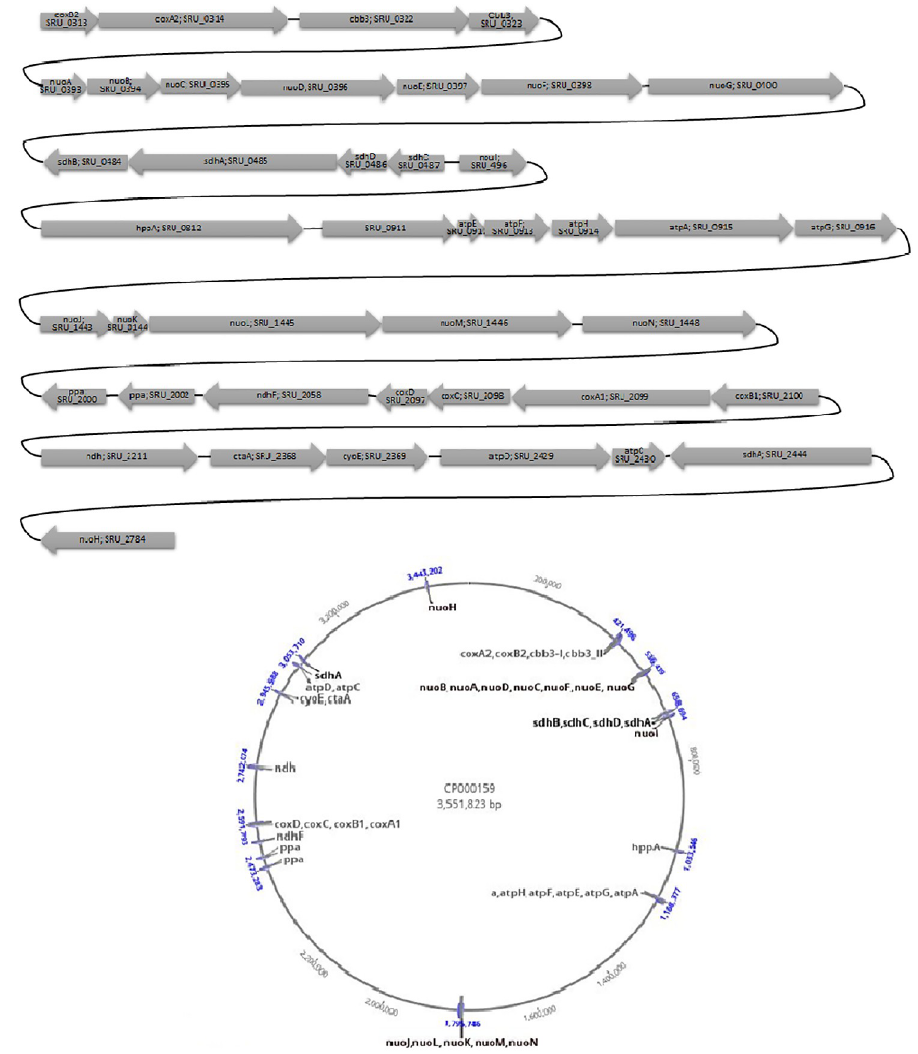
Fig 2. Phosphorylation oxidative genes in S . ruber . (A). gene direction and related position of their related position to each other. (B). distribution of gene clusters in the genome. Totally 42 genes were related to oxidative phosphorylation reactions which are localized at 14 segments of the main